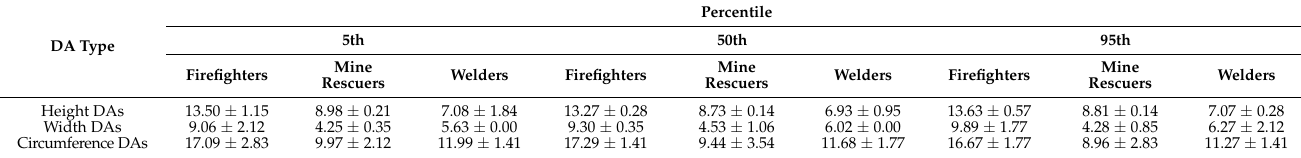
Table 3. Mean height, width, and circumference dimensional allowances (DAs) with standard deviation (SD) for the 5th, 50th, and 95th percentile groups of participants wearing firefighting, mine rescue, and welding PPE